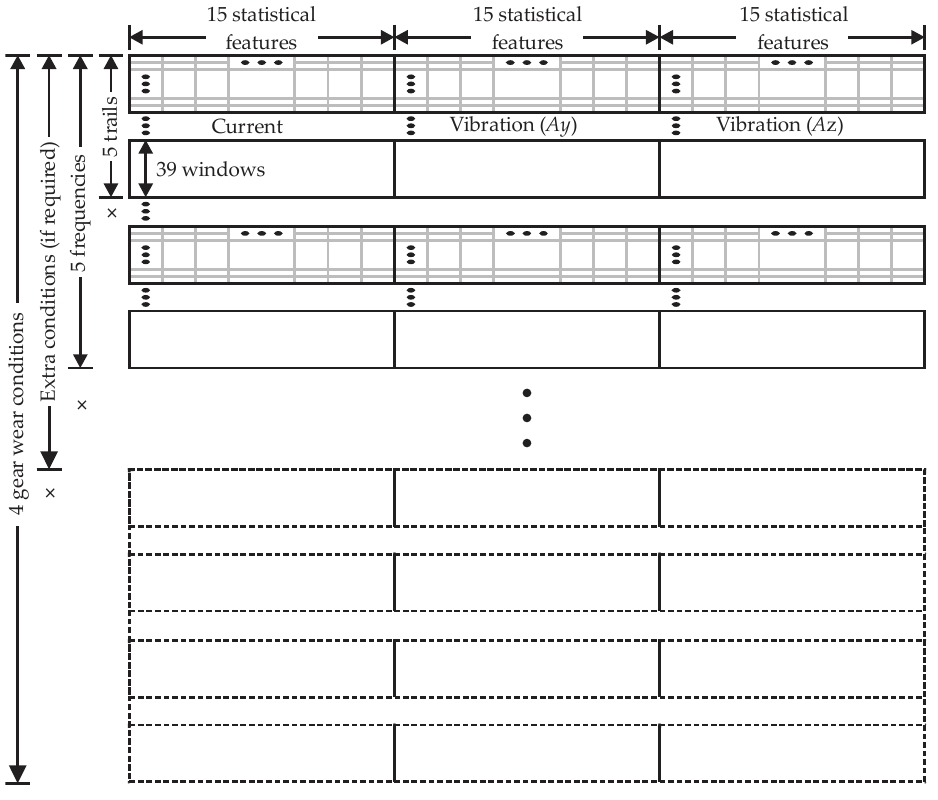
Figure 6. Arrangement of the matrix of features of high dimensionality.